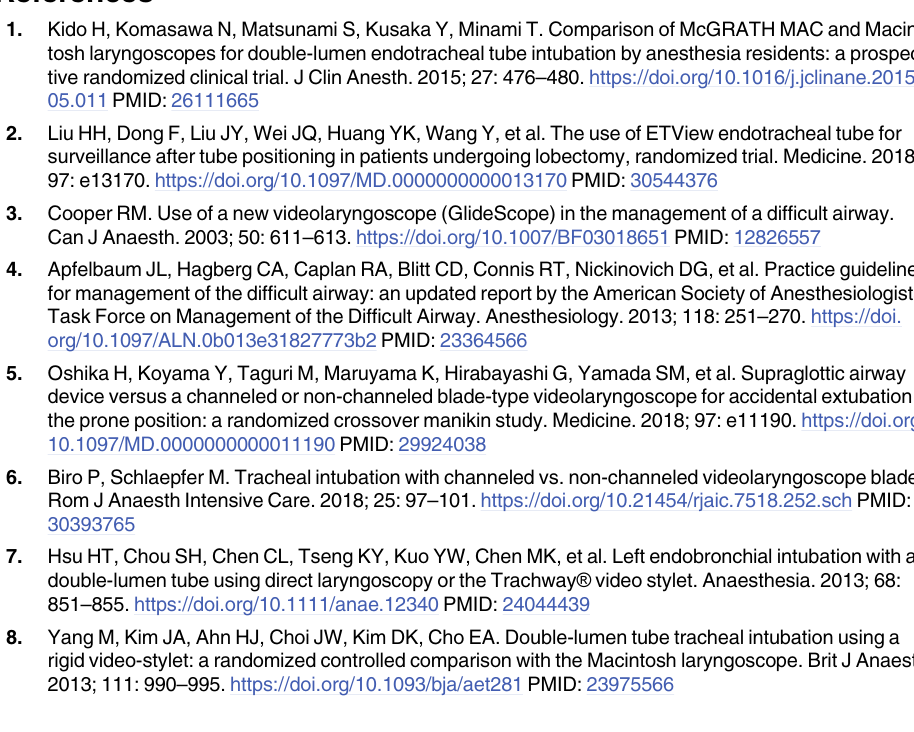
S2 Table. Clinical characteristics for enrolled